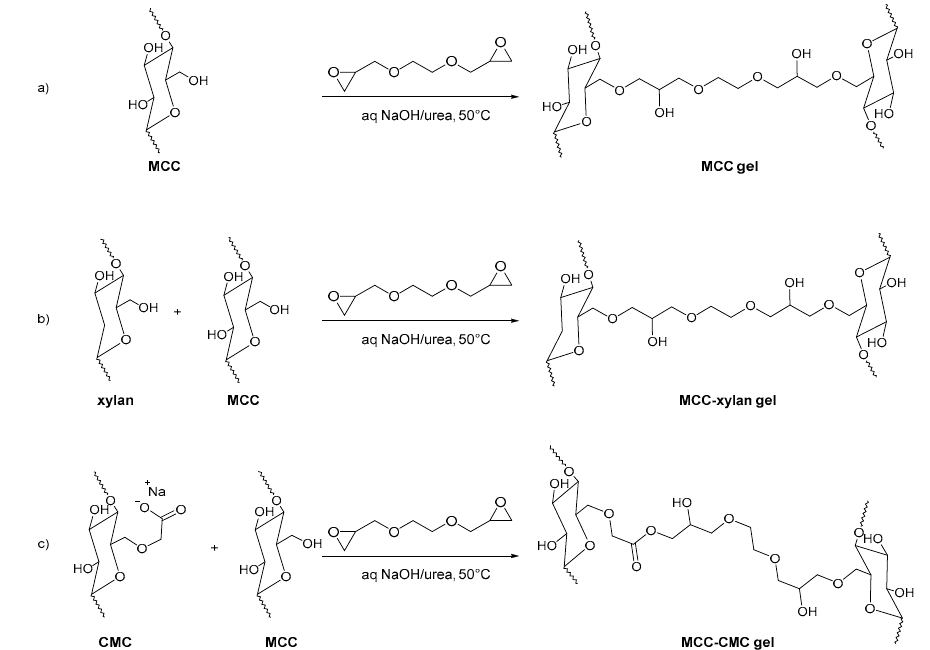
Figure 15. Hydrogel formation: ( a ) MCC gel; ( b ) MCC-xylan gel; ( c ) MCC-CMC gel.